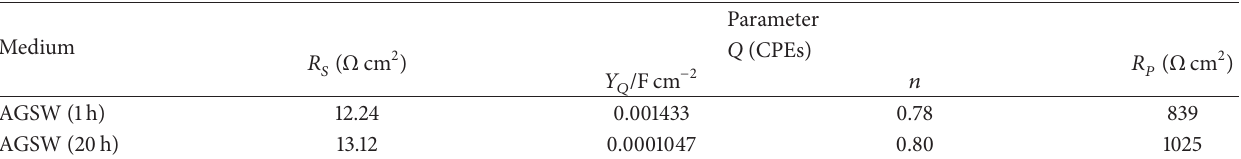
Table 1: EIS parameters obtained by fitting the Nyquist plots shown in Figure 2 with the equivalent circuit shown in Figure 3 for X70 steel after 1 h and 20 h immersion in Arabian Gulf seawater.